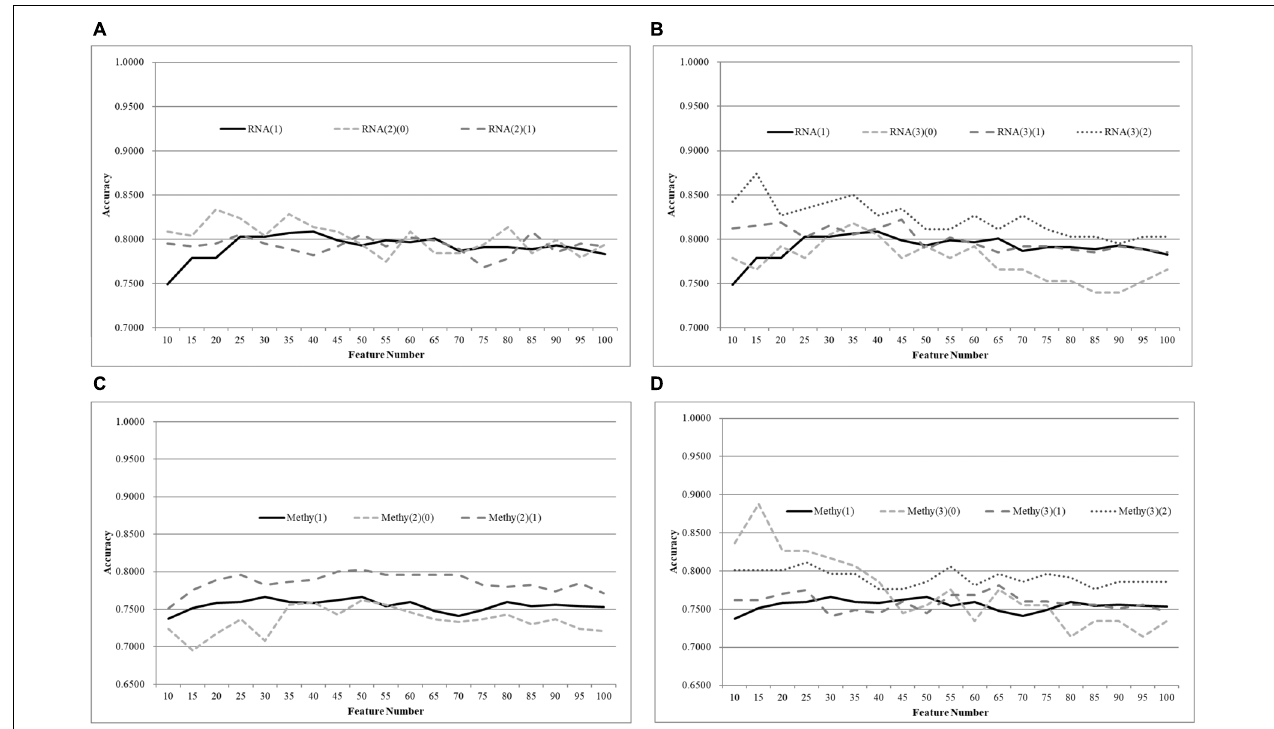
FIGURE 7 | Comparison of early-stage breast cancer detection models with different age groups based on both transcriptome and methylome data. Transcriptomes of the patients were split into (A) two groups and (B) three groups with equally-sized age ranges. The methylomes were split into (C) two groups and (D) three groups in the same way. The horizontal axis shows the numbers of features chosen by TriVote and the vertical axis shows the 10-fold cross-validation accuracy of the classifier XGB. F -test was used to generate the initial subset of the 1000 top-ranked features.